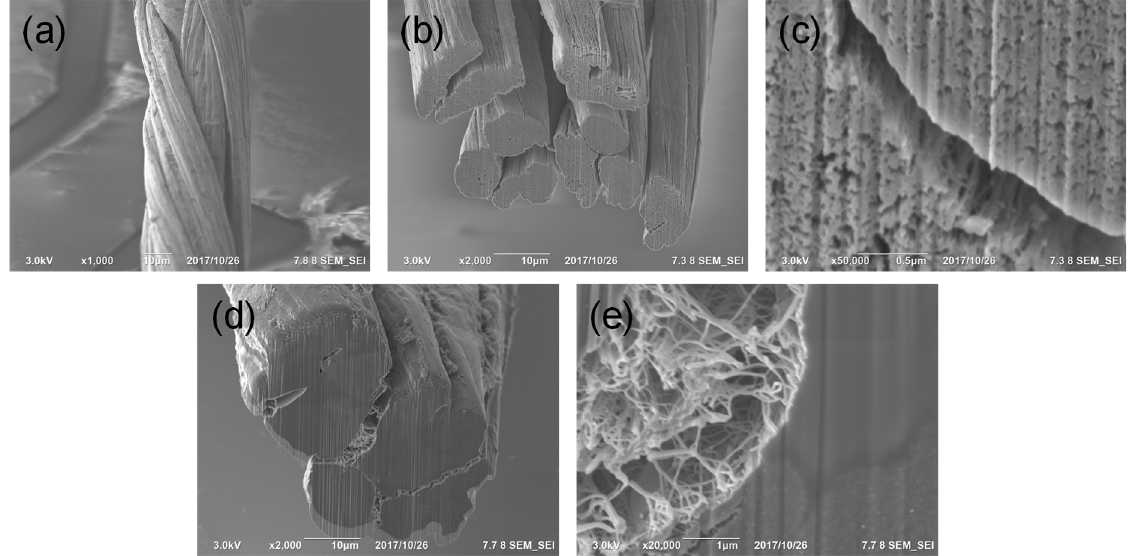
Figure 3. ( a ) Scanning electron microscope image, ( b ) cross-section image, and ( c ) high-magnification image of the as-twisted multifilament CNTF. ( d ) Cross-section image and ( e ) high-magnification image of Resin #2-infiltrated multifilament CNTF.